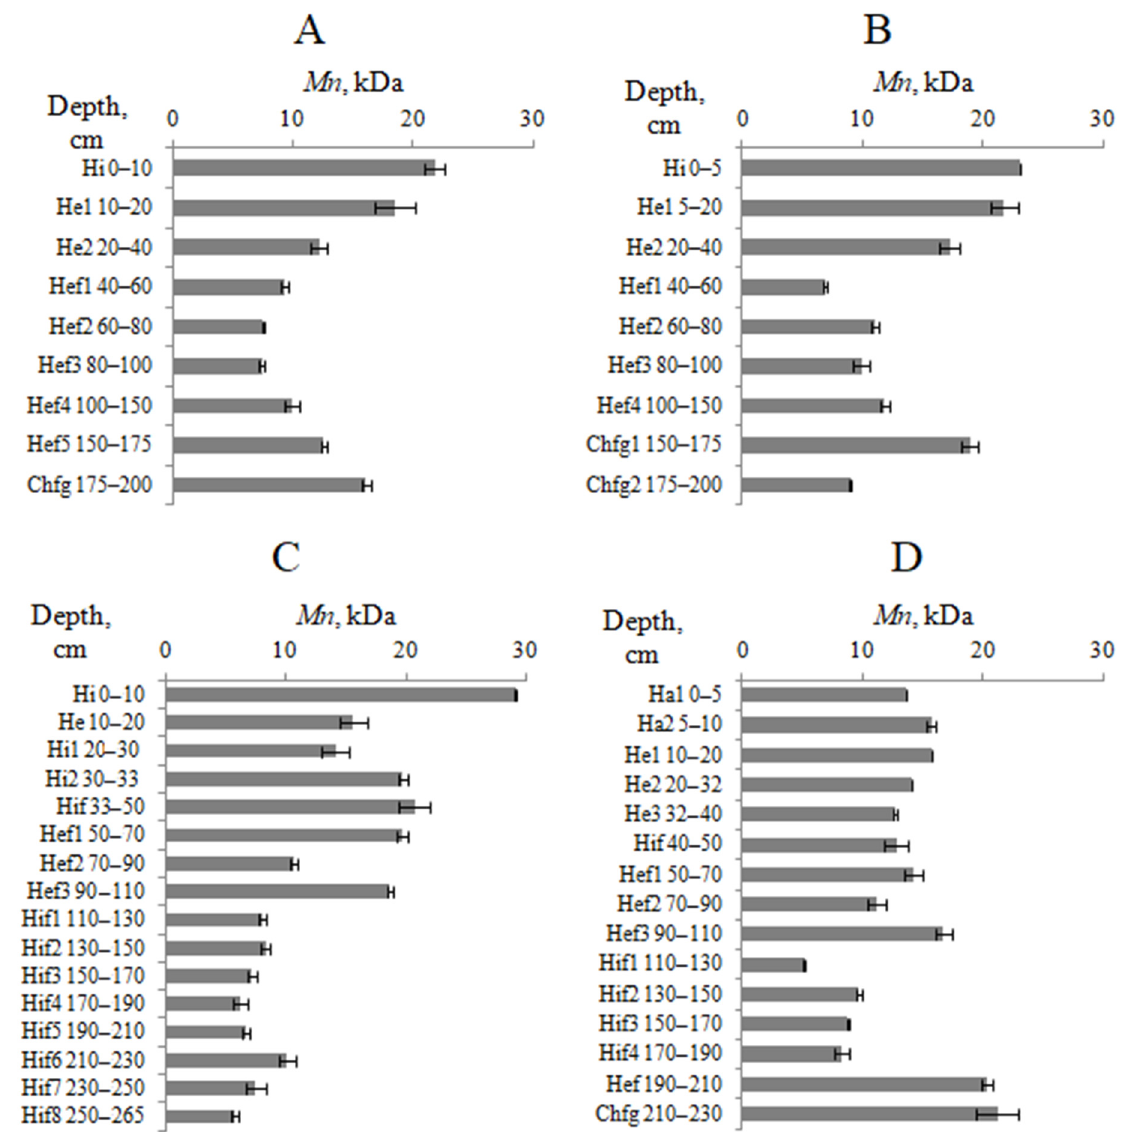
Figure 6. Number average molecular weight of the HAs from the Plot 1-1 ( A ), Plot 1-2 ( B ), Plot 2-1 ( C ) and Plot 2-2 ( D ).